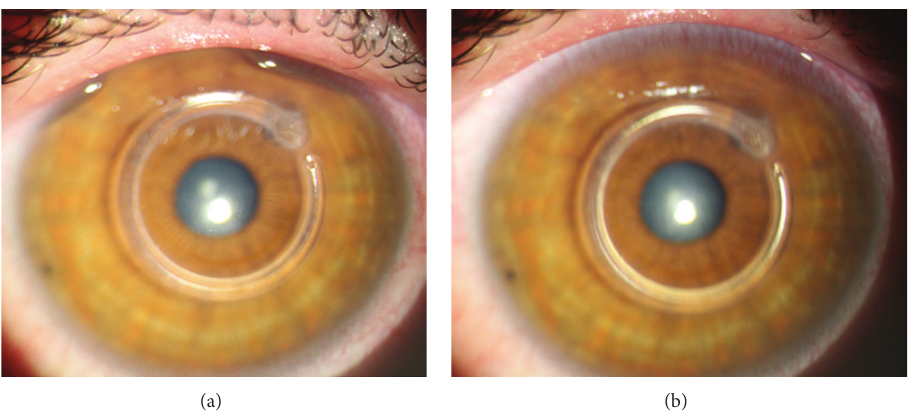
Figure 1: Slit-lamp examination of an eye with keratoconus one month and 3 months after Keraring 355 ∘ ICR implantation.